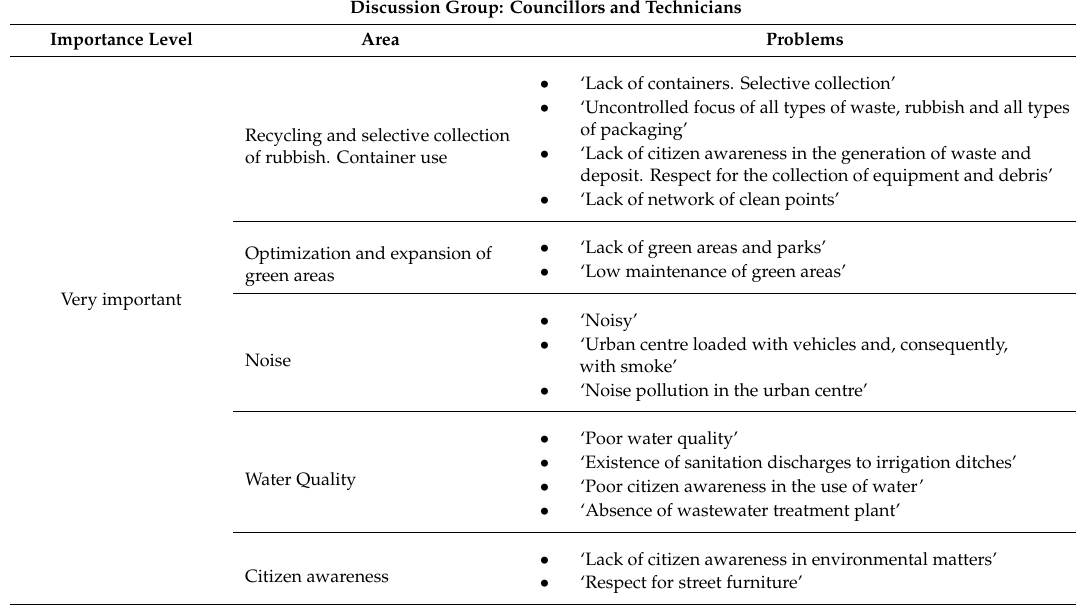
Table 9. Socio-environmental problems extracted from the discussion group ‘councillors and